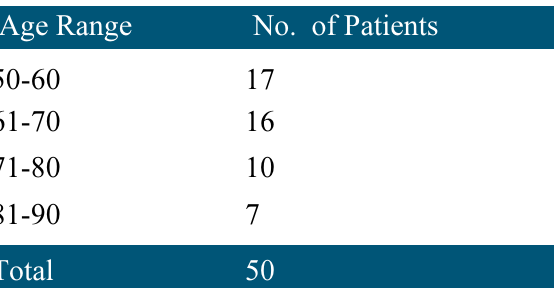
Figure 2: Patient with signicant stenosis Table 1: Age distribution